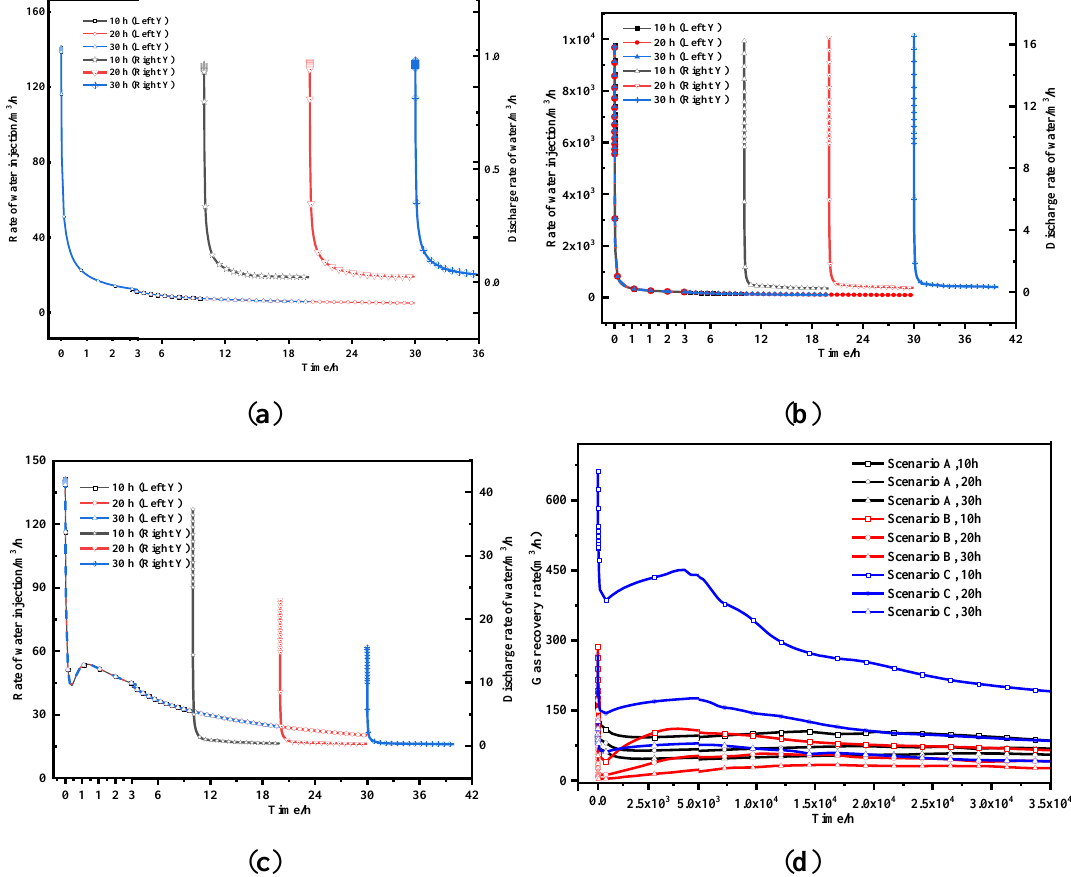
Figure 10. The water injection rate of ( a ) Scenarios A, ( b ) Scenarios B, ( c ) Scenarios C and ( d ) the gas production rate of the three scenarios.